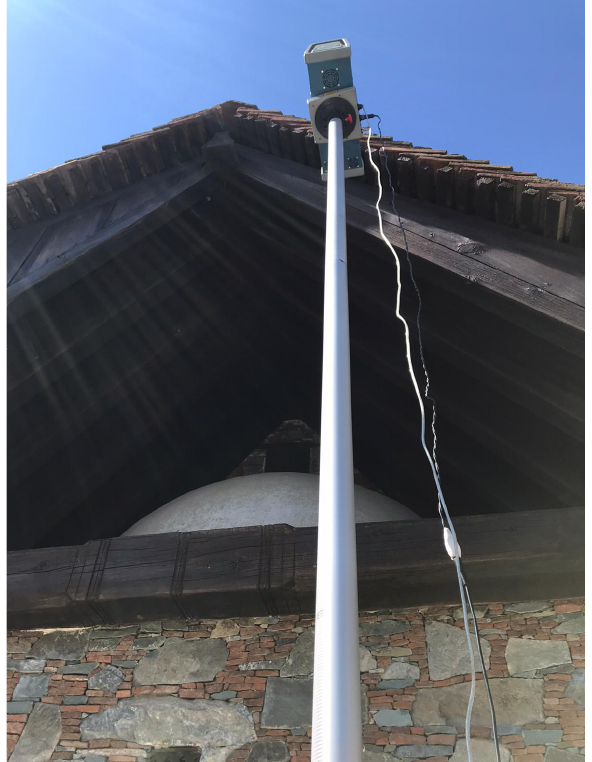
Figure 4. Metamorphosis tou Sotiros, Palaichori, TLS 3D survey, exterior.